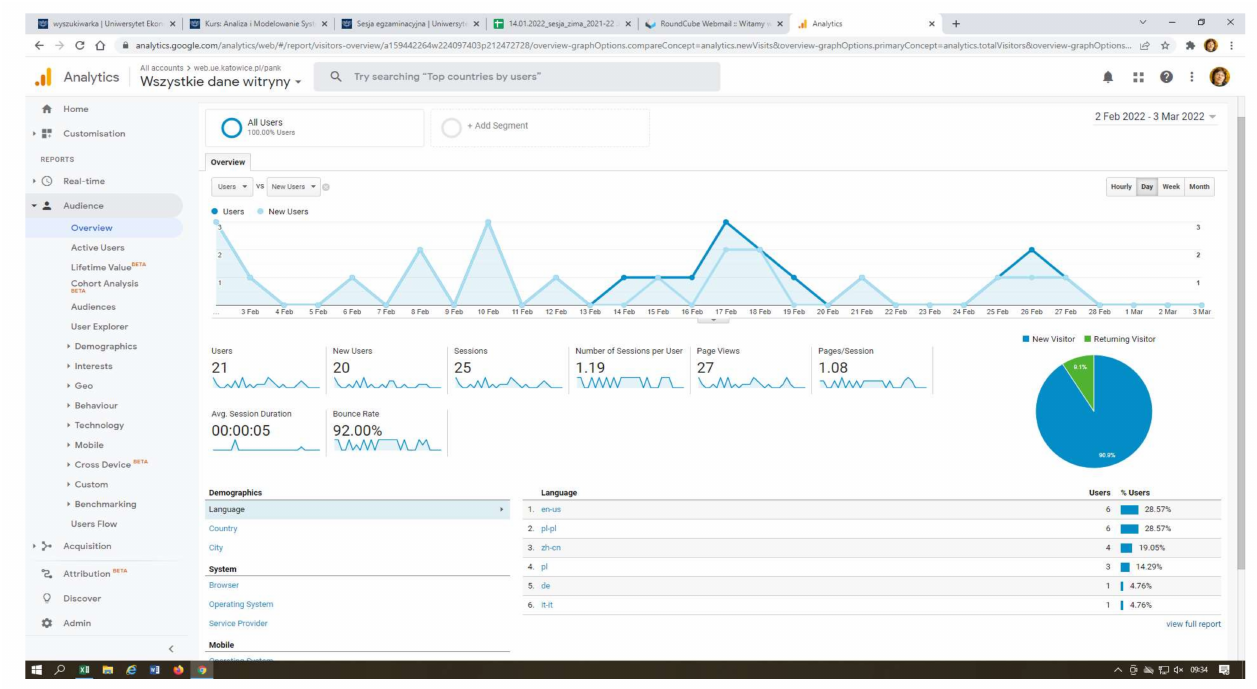
Figure 2. Google Analytics selected metrics for author’s website http://web.ue.katowice.pl/pank/ (accessed on 6 February